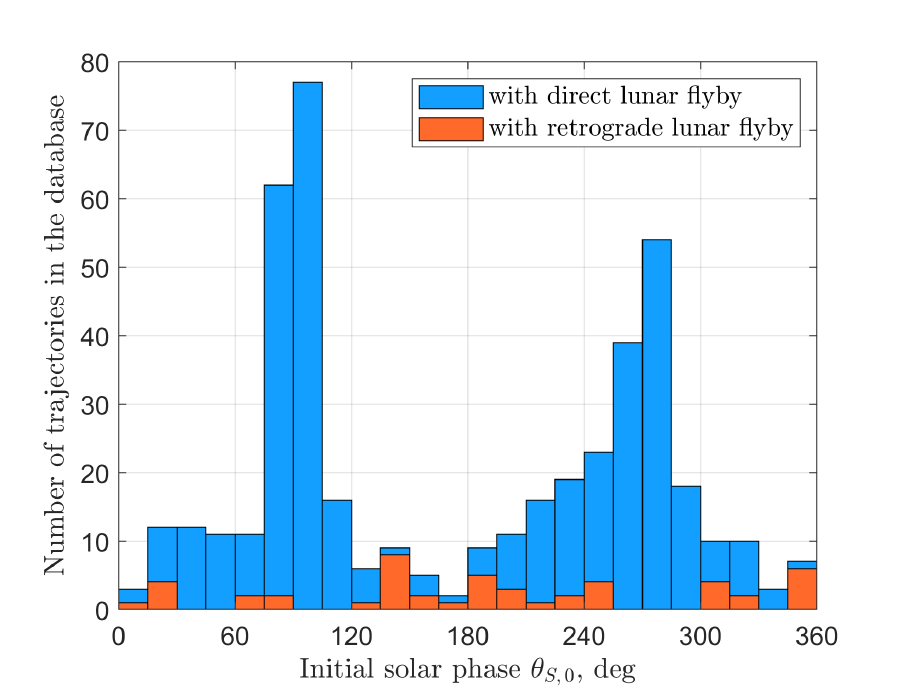
Figure 18. Distribution of solar phase angles at the moment of TLI burn execution for SALT trajectories with a lunar flyby. Two distinct peaks at about 95 deg and 275 deg correspond to the 2nd and 4th quadrant trajectories with a direct flyby. For retrograde flyby trajectories, the pattern is not so clear, but small peaks around 140 deg and 350 deg values could be